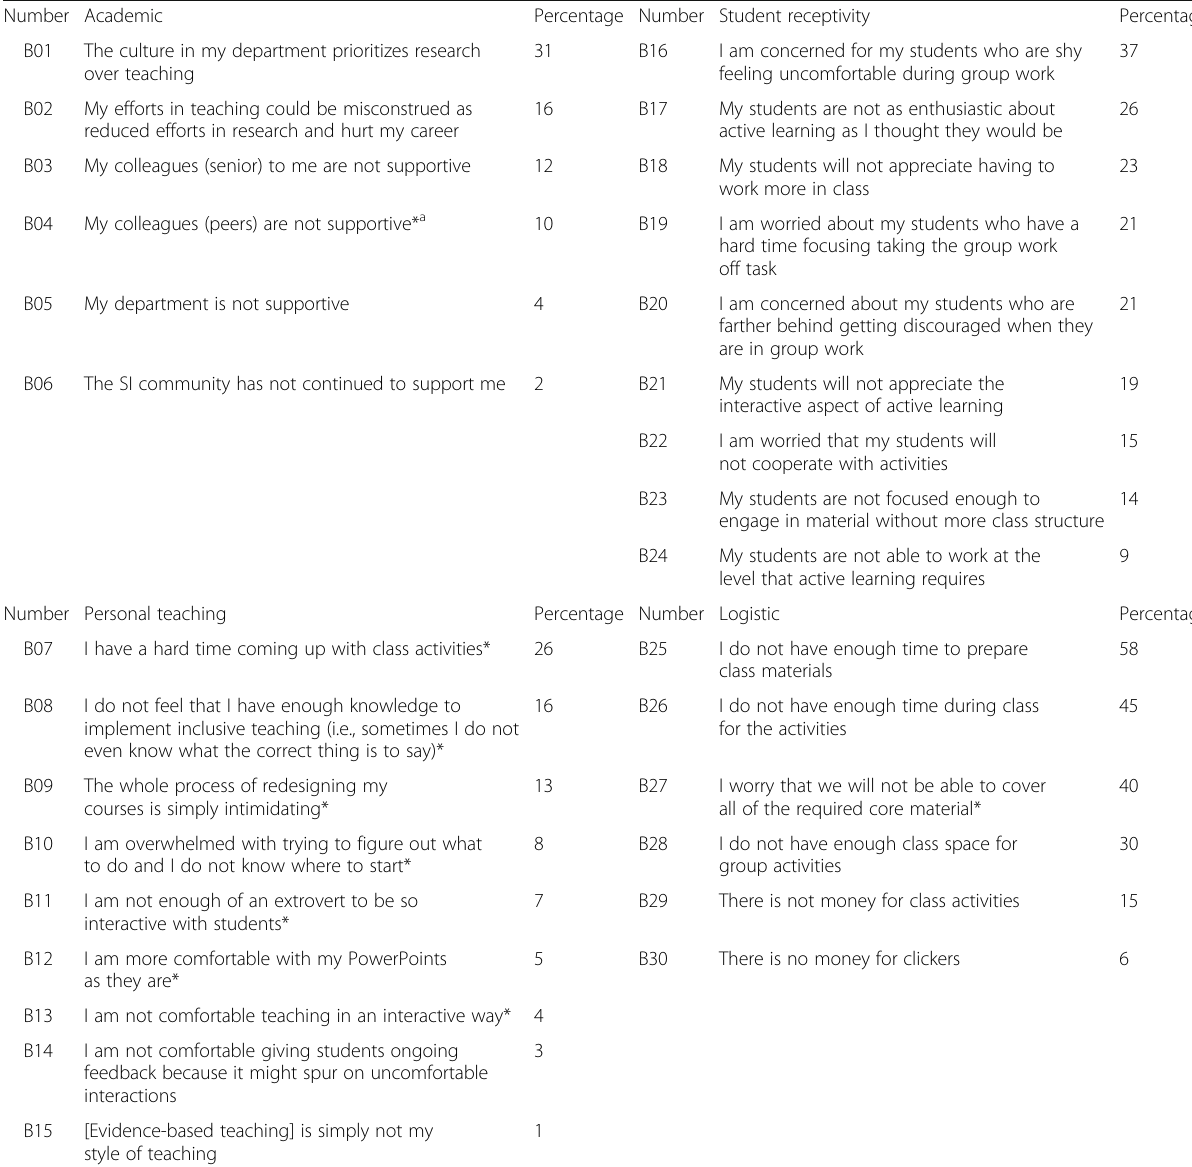
Table 3 Categories of barriers with the percentage of instructors who perceive each item ( n = 584) Number Academic Percentage Number Student receptivity